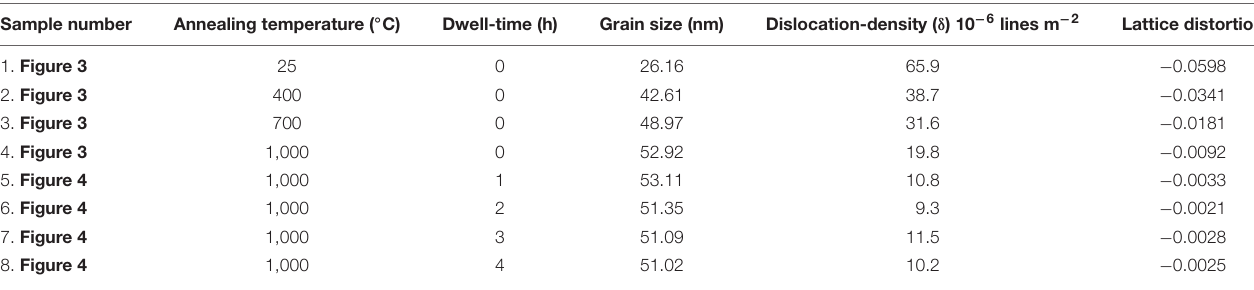
TABLE 1 | Variation of grain size, dislocation density, and lattice distortion for the ITO films. Sample